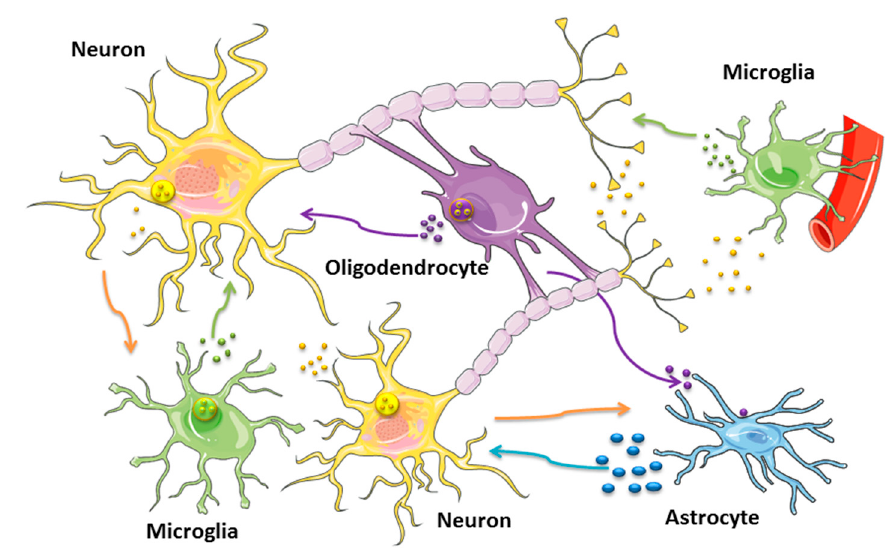
Figure 2. Exosomes in intercellular cross-talk involving CNS cells. The schematic representation illustrates the release of exosomes from major neural cells such as neurons, astrocytes, microglia and oligodendrocytes. NDEs (yellow particles and arrows) can be released from both the somato-dendritic compartments of neurons and from the presynaptic regions and can modulate activity of microglia, astrocytes and oligodendrocytes. ODEs (violet particles and arrows) can transfer myelin proteins and trophic factors to other neurons and astrocytes, providing metabolic supports. ADEs (blue particles and arrows) containing heat shock proteins and synapsin I can be taken up by neurons promoting their survival and development. MDEs (green particles and arrows) are involved in the neuroimmune communication, influencing neurite outgrowth, modulating neuronal activity and firing. See Table 1 and text for complete details.